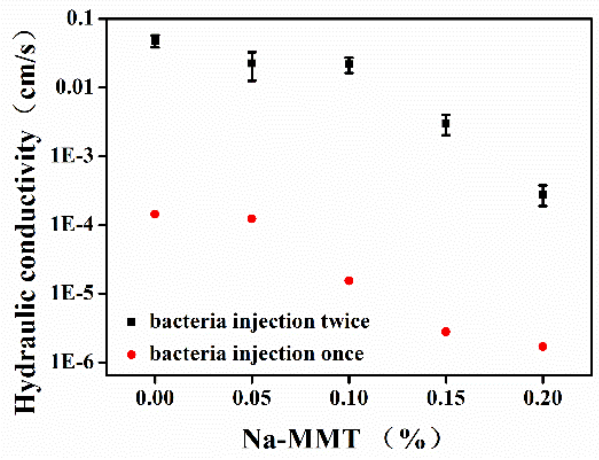
Figure 8. XRD patterns of CaCO 3 precipitates catalyzed by bacteria (TCS = 100) without ( a ) and with 0.25% Na-MMT ( b ).